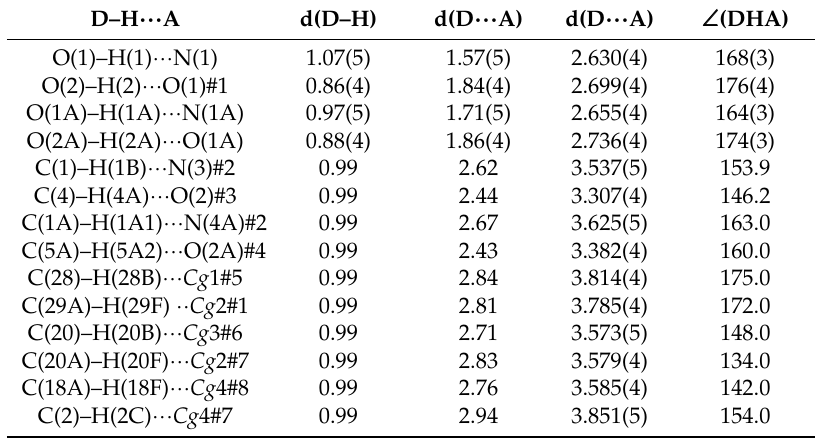
Table 2. Hydrogen bonds for ternary cocrystal units I and II [Å and ◦